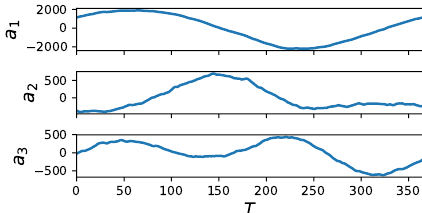
Figure 8. Visualization of the first three POD modes (top left to right) and POD coefficients (bottom) for the sea surface temperature data.